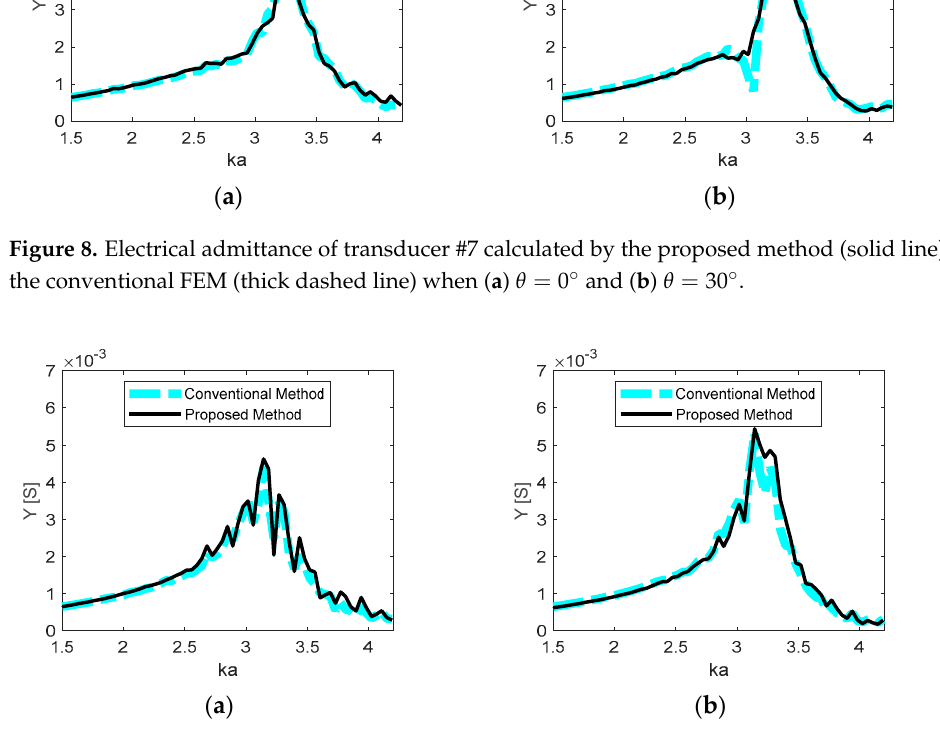
Figure 10. Voltage-to-velocity transfer function of transducer #7 calculated by the proposed method (solid line) and the conventional FEM (thick dashed line) when ( a ) θ = 0 ◦ and ( b ) θ = 30 ◦ .